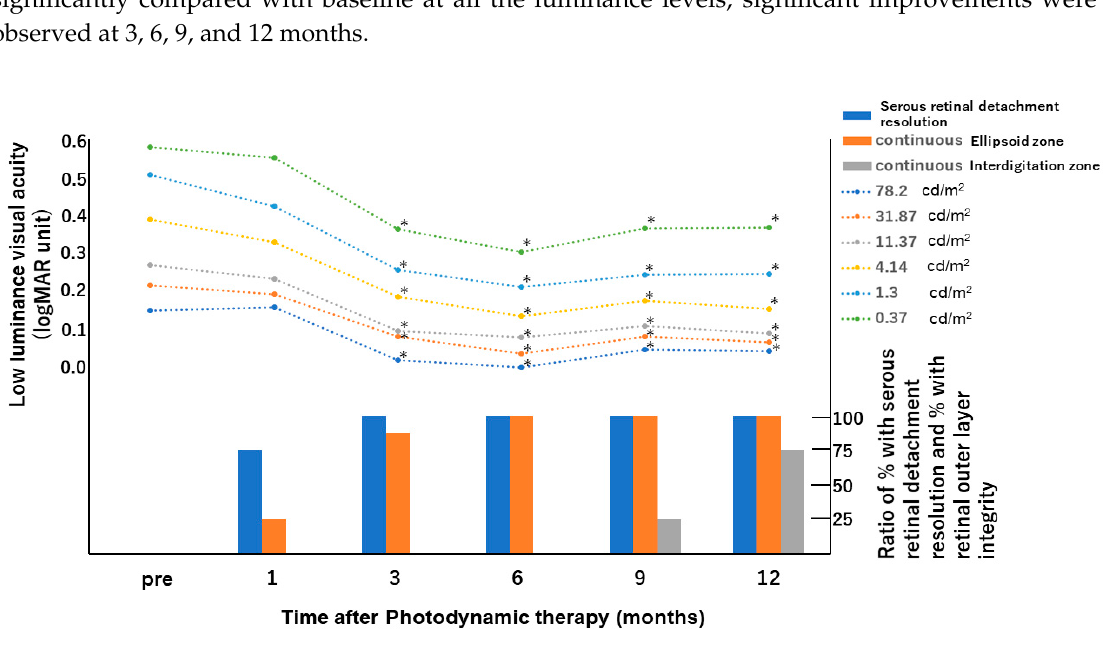
Figure 1. Mean change from baseline of low luminance visual acuity (LLVA), percentage of serous retinal detachment resolution, and integrity of retinal outer layer determined on images of horizontal optical coherence tomographic scans before and after half-dose photodynamic therapy. LLVA is significantly better at 3, 6, and 12 months after surgery than at baseline, at all luminance levels. * p < 0.05. The time courses of recovery of the ellipsoid zone and improvement of LLVA are almost the same.